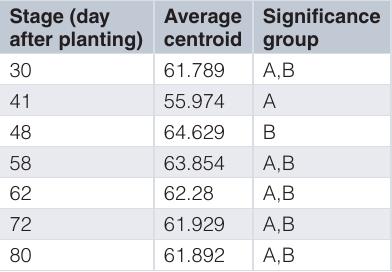
Table 2. SEM Permdisp Community Structure Comparisons. Significance groups with different letters are significantly different by pairwise test with a Bonferroni multiple-test-correction threshold of